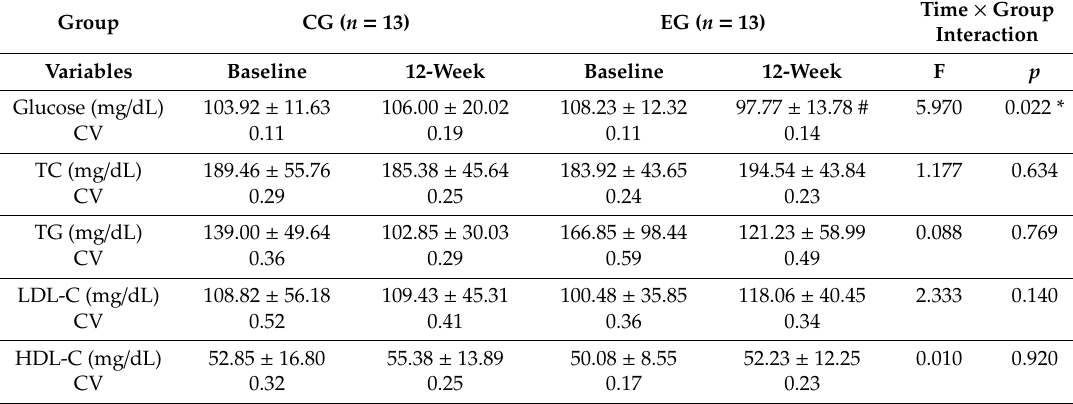
Table 3. The changes in the lipid profile.